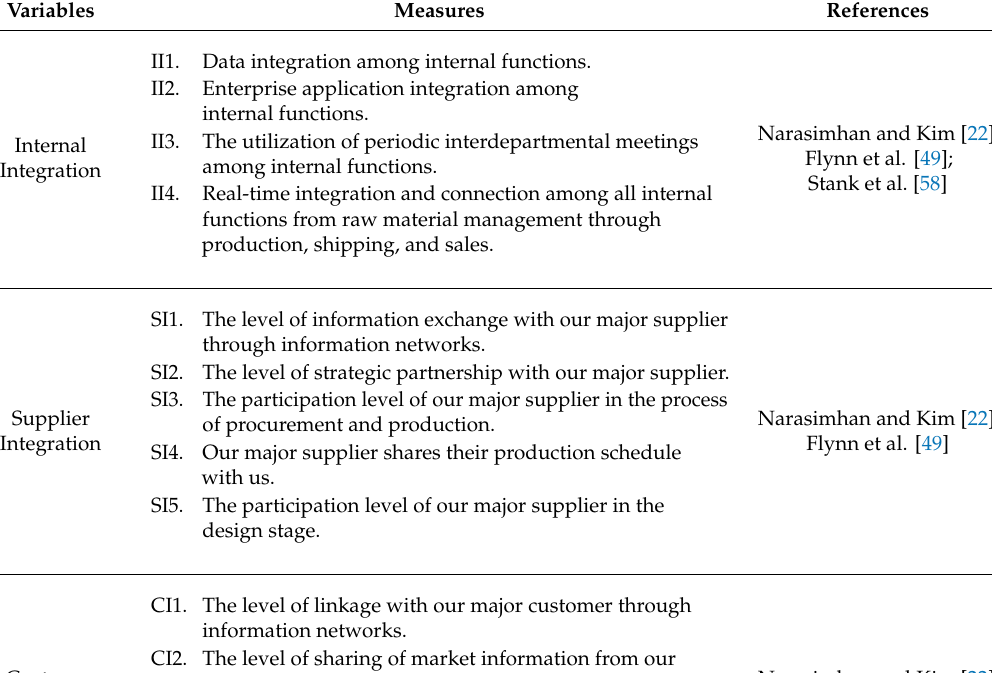
Table 1. Variables and corresponding